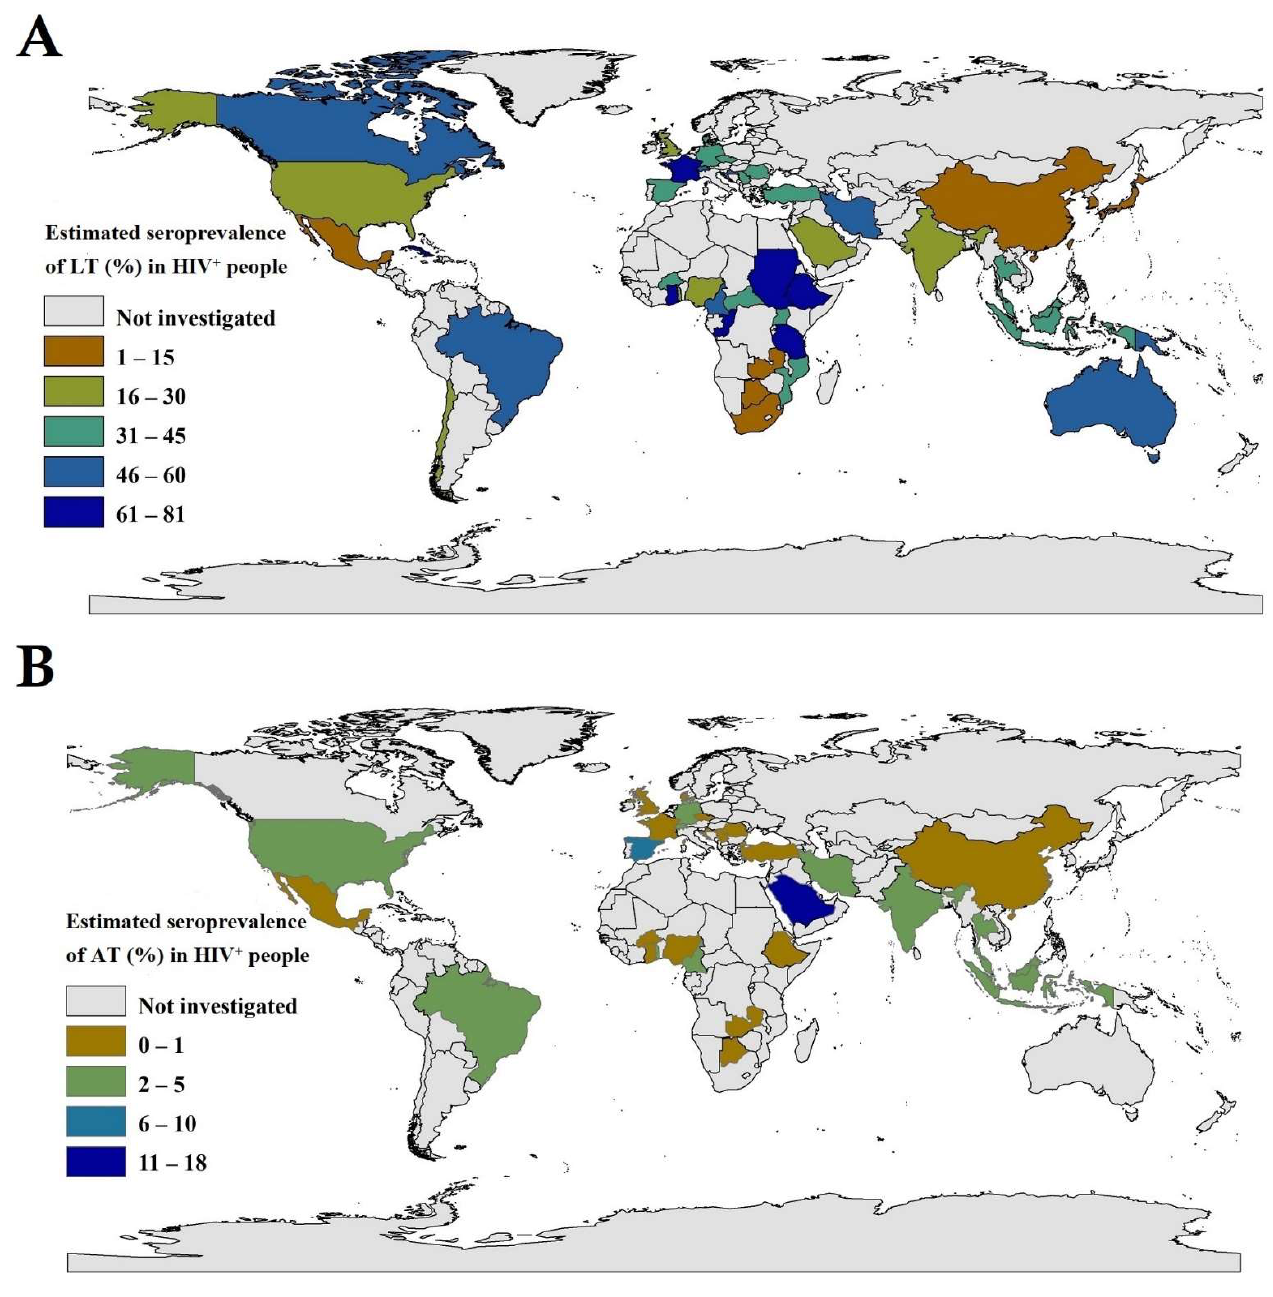
Figure 1. Seroprevalence estimates for latent or acute T. gondii infections (( A )—LT and ( B )—AT) in HIV + people in different countries around the world using the geographic information system (GIS).